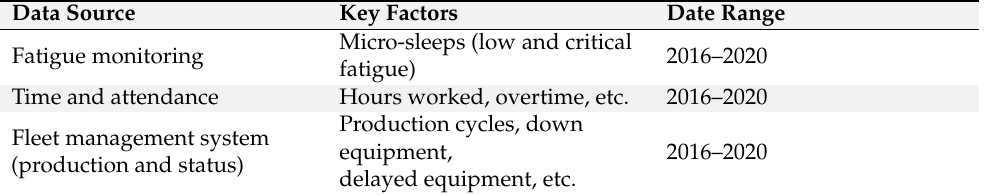
Table 1. Data sets details.